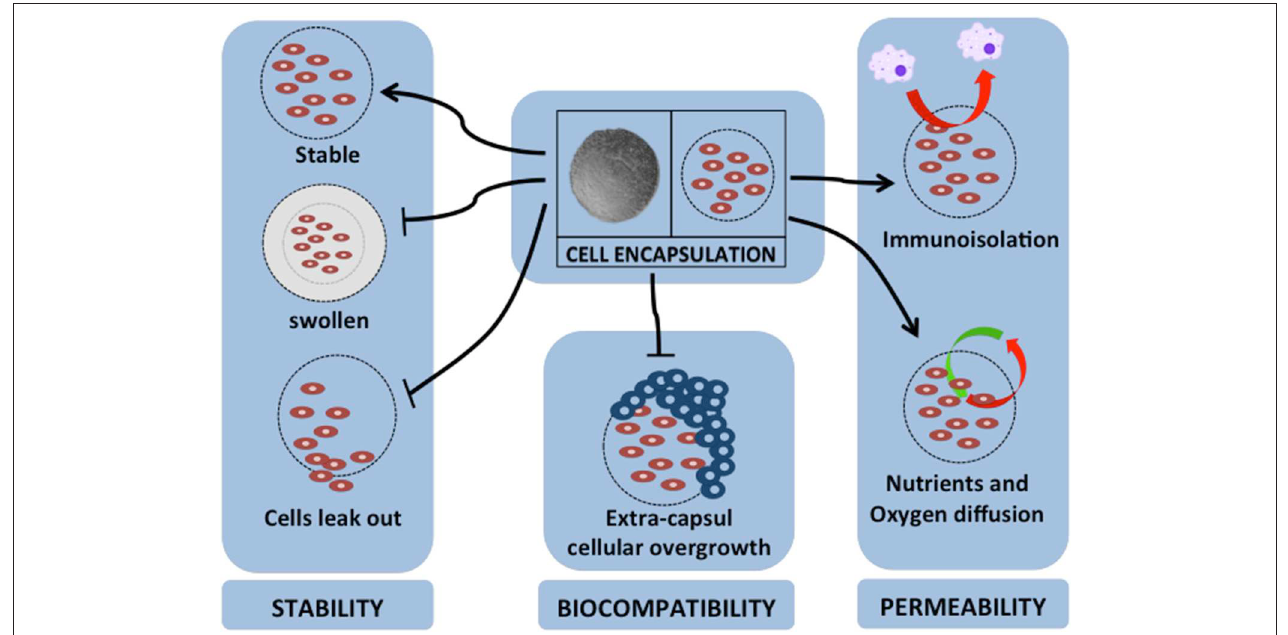
FIGURE 2 | Major factors for cell encapsulation materials. The successful application of cell encapsulation depends on the important factors of encapsulation properties. These properties are as follows: (1) for stability of long-term grafting, the encapsulation material should maintain its own structure in a stable geometrical form, not swell due to the host environment, and should immobilize the cells to prevent leaking; (2) it should have biocompatibility to protect extra-capsular cellular overgrowth that is associated with fibrotic response; (3) it should have permeability for nutrient and oxygen diffusion, provide immunoisolation by avoiding cell-to-cell attachment, and act as barrier for pro-inflammatory